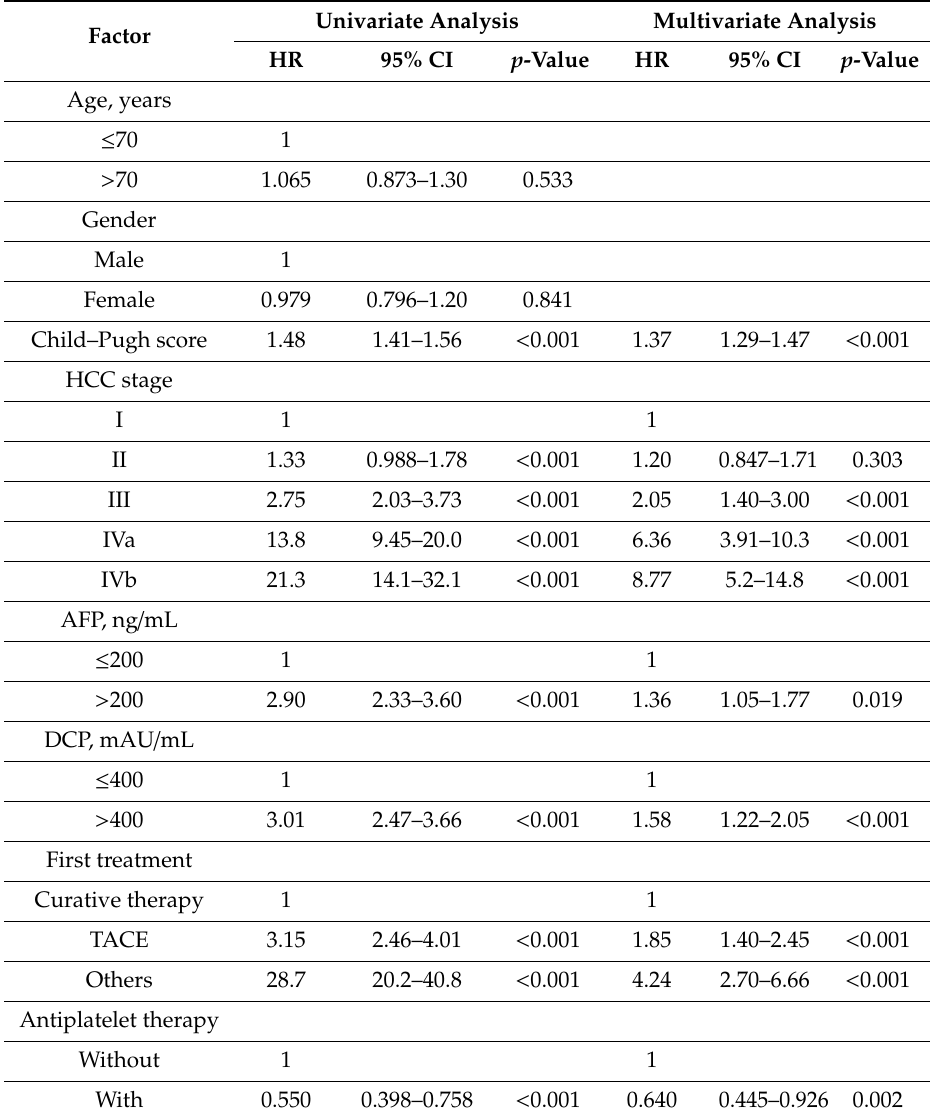
Table 2. Baseline factors associated with liver-related deaths in all patients in univariate and multivariate Cox progression analyses. Univariate Analysis Multivariate Analysis Factor HR 95% CI p